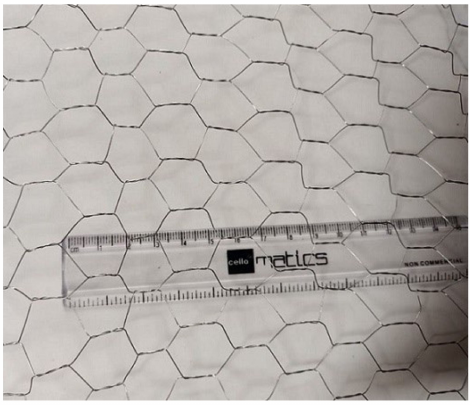
Figure 1. Chicken